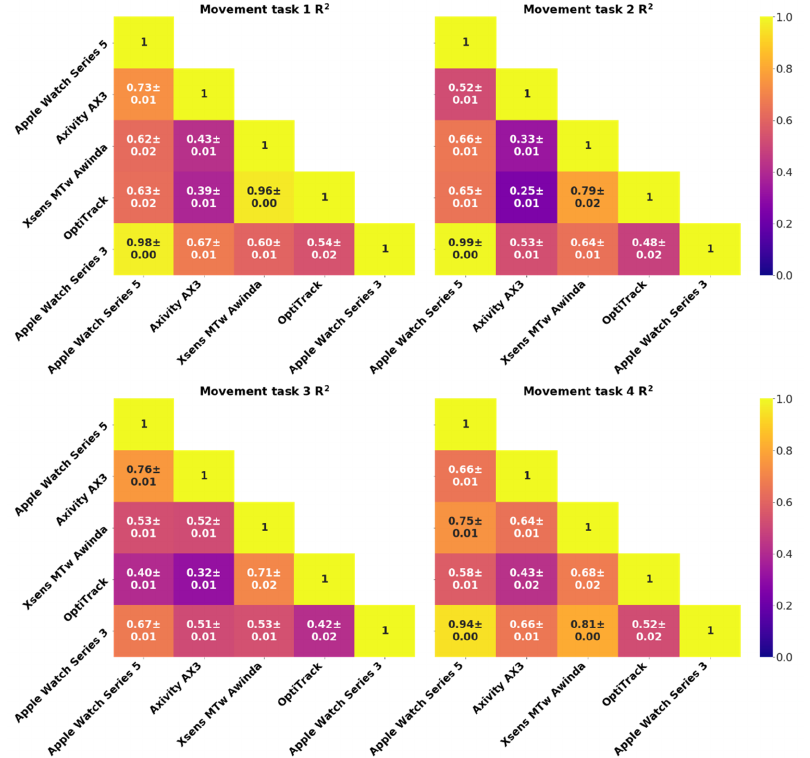
Figure A2. Depicts a breakdown of the acceleration R 2 result in Figure 4a for each of the 4 movement tasks. Displayed R 2 in the figure are rounded. Sensors 2020 , 20 , x FOR PEER REVIEW